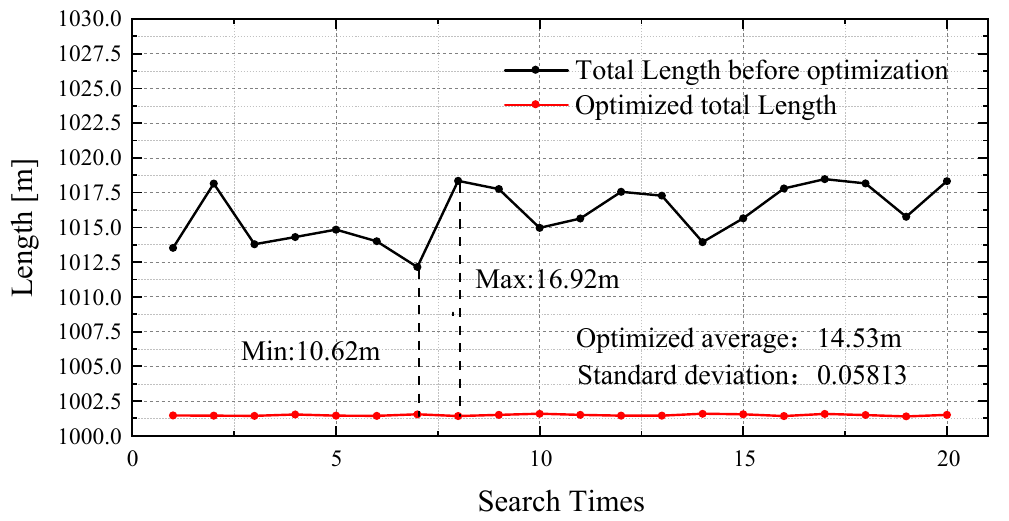
Figure 14. Optimal length of trajectories by searching 20 times.